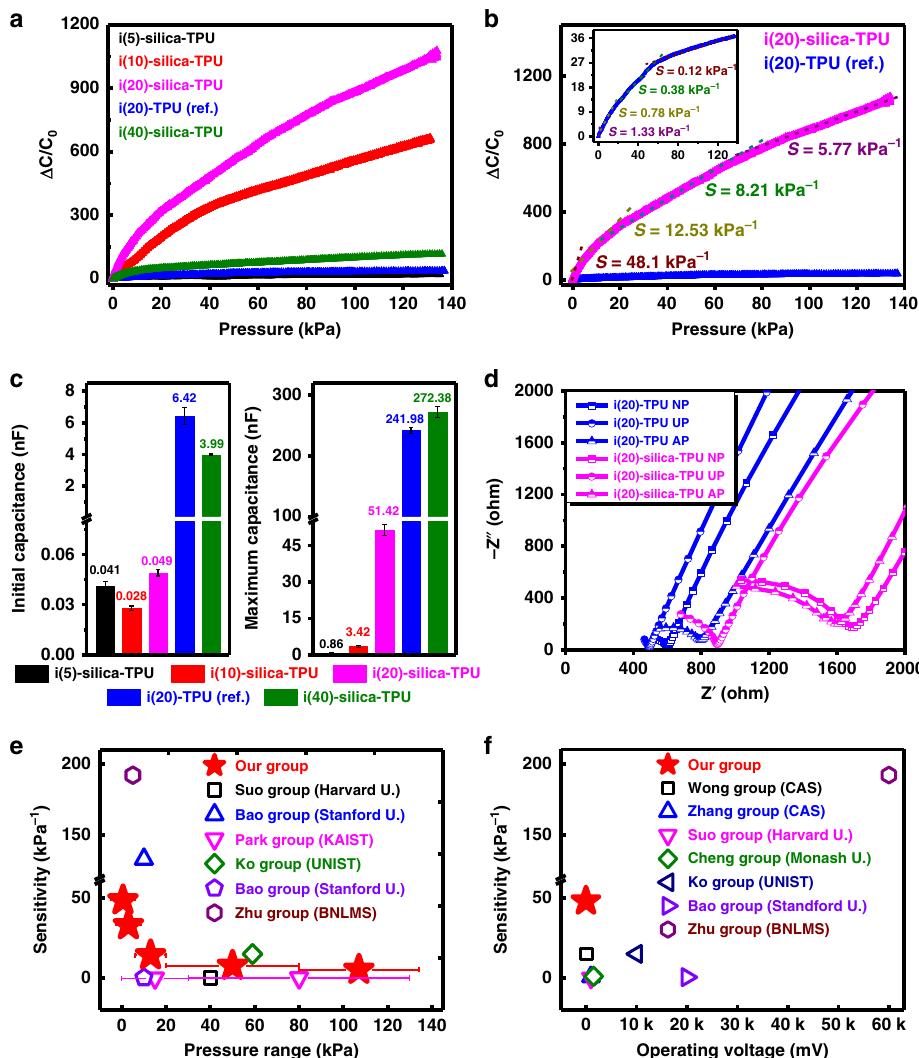
Fig. 5 Ultrasensitive mechanotransduction in IL – silica – TPU SMHIP. a Pressure response of IL – silica – TPU SMHIP pressure sensors under static